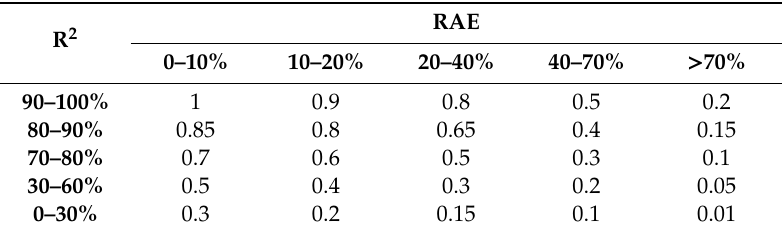
Table 3. Q-learning reward matrix for error admissible threshold.